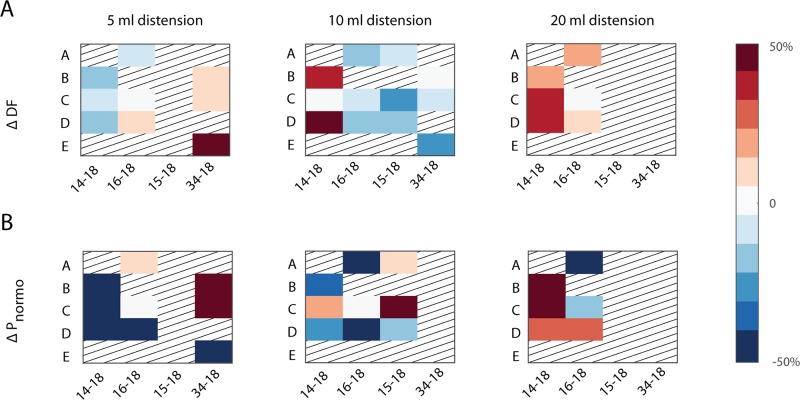
Effect of gastric volume on DF and Pnorm.A) Heatmap of the change in DF and B) percentage of total power in the normogastric range in response to gastric distension at 5, 10 and 20 ml (columns) across subjects and gastric segments for animals B, C, D, E, H. Grating represents gastric segments that did not display a DF at baseline or trials that were not administered.